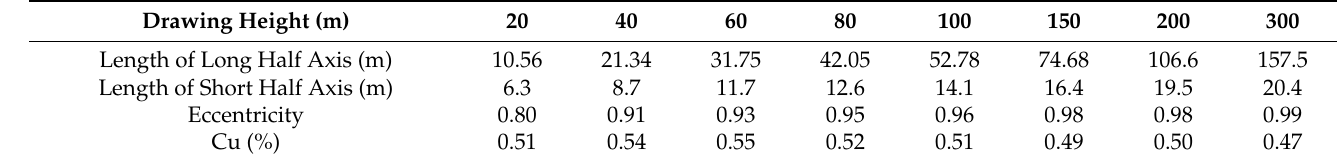
Table 2. Parameters of the IEZ.